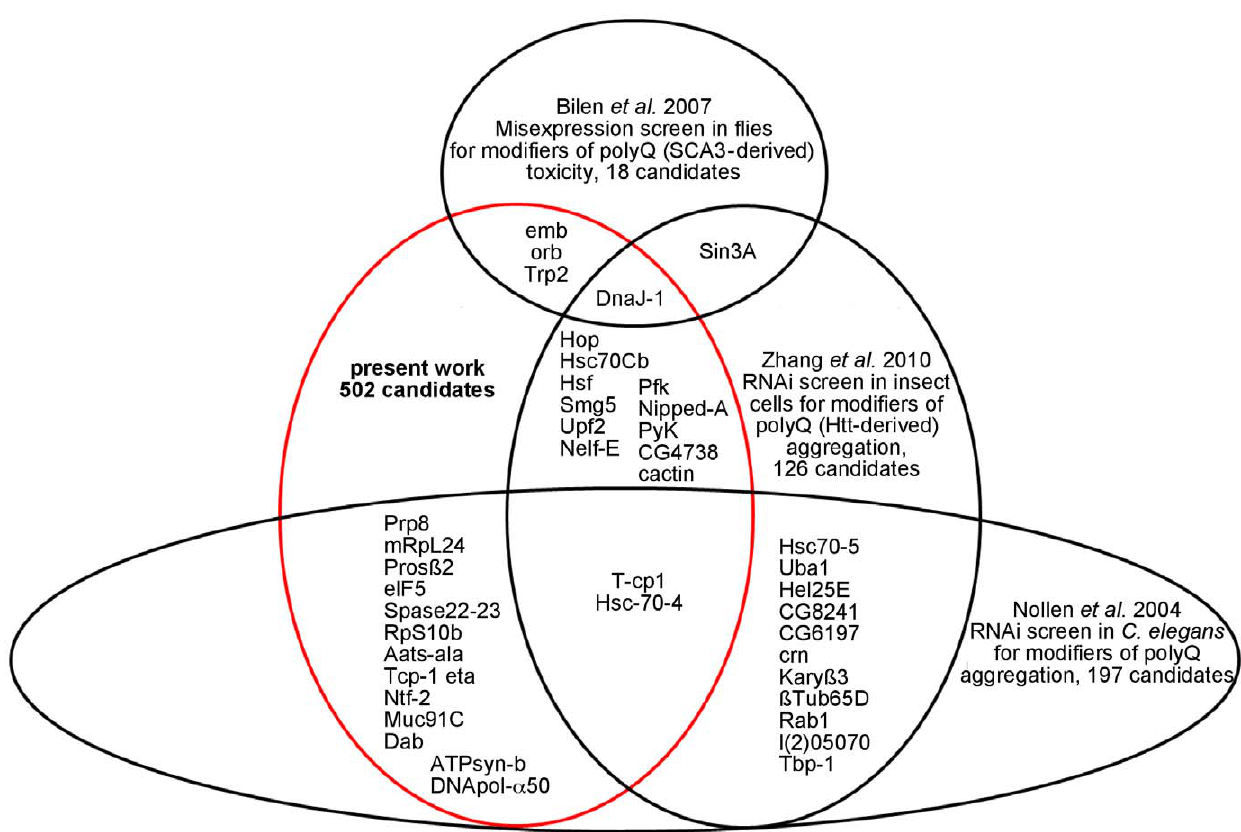
Figure 4. Overlap between screens for genetic modifiers of polyQ-induced toxicity or aggregation. The Venn-like diagram displays only candidate genes shared by the different screens. Mode of modification (enhancement/suppression) is not addressed, due to the different readouts (aggregation/toxicity), model systems ( Drosophila , insect cells, C. elegans ) and elongated polyQ-containing proteins used in the diverse screening approaches.